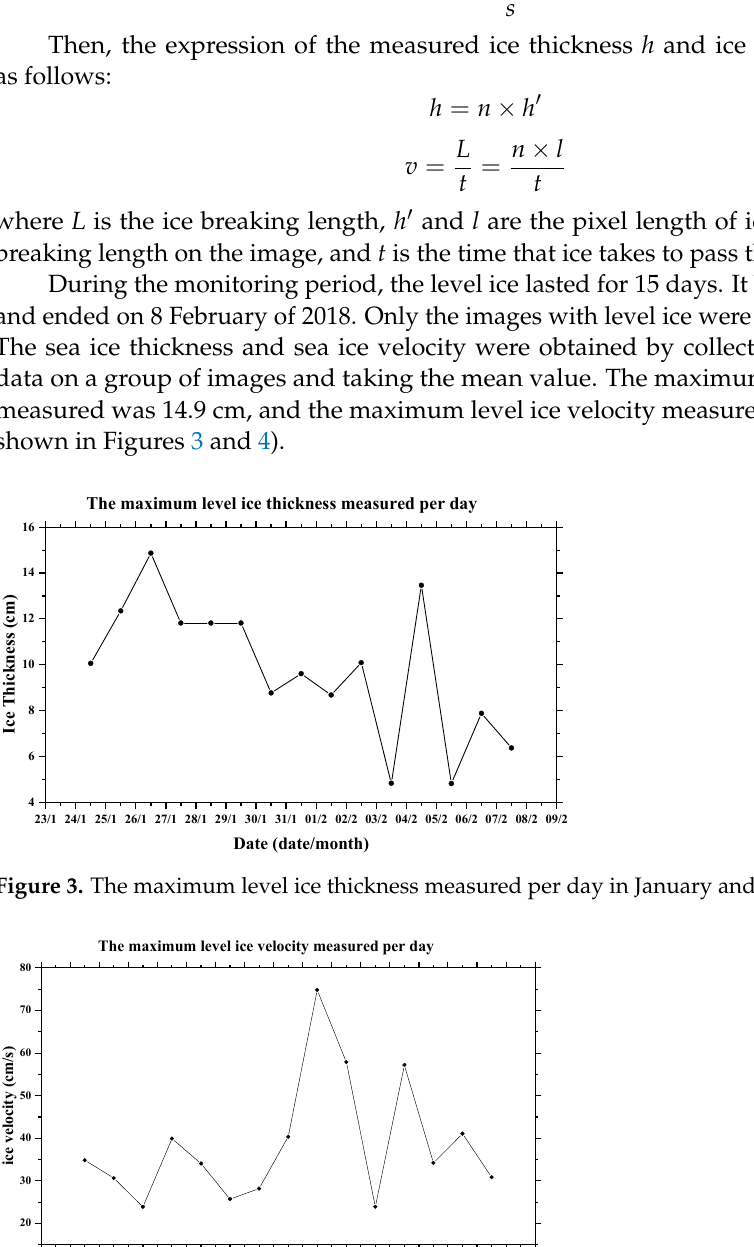
Figure 2. Image monitoring methods of sea ice factors.